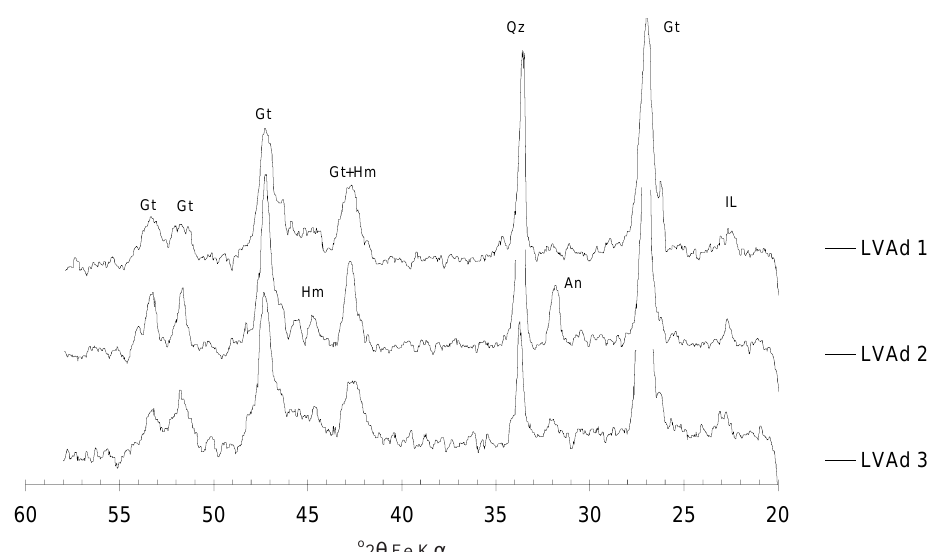
Figura 5. Difratogramas de Raios-X da fração argila tratada com NaOH 5 mol L -1 dos Latossolos estudados (montagem sem orientação). Gt – Goethita; Hm – Hematita; An – Anatásio; IL – Ilmenita; Qz – Quartzo, incluído como padrão